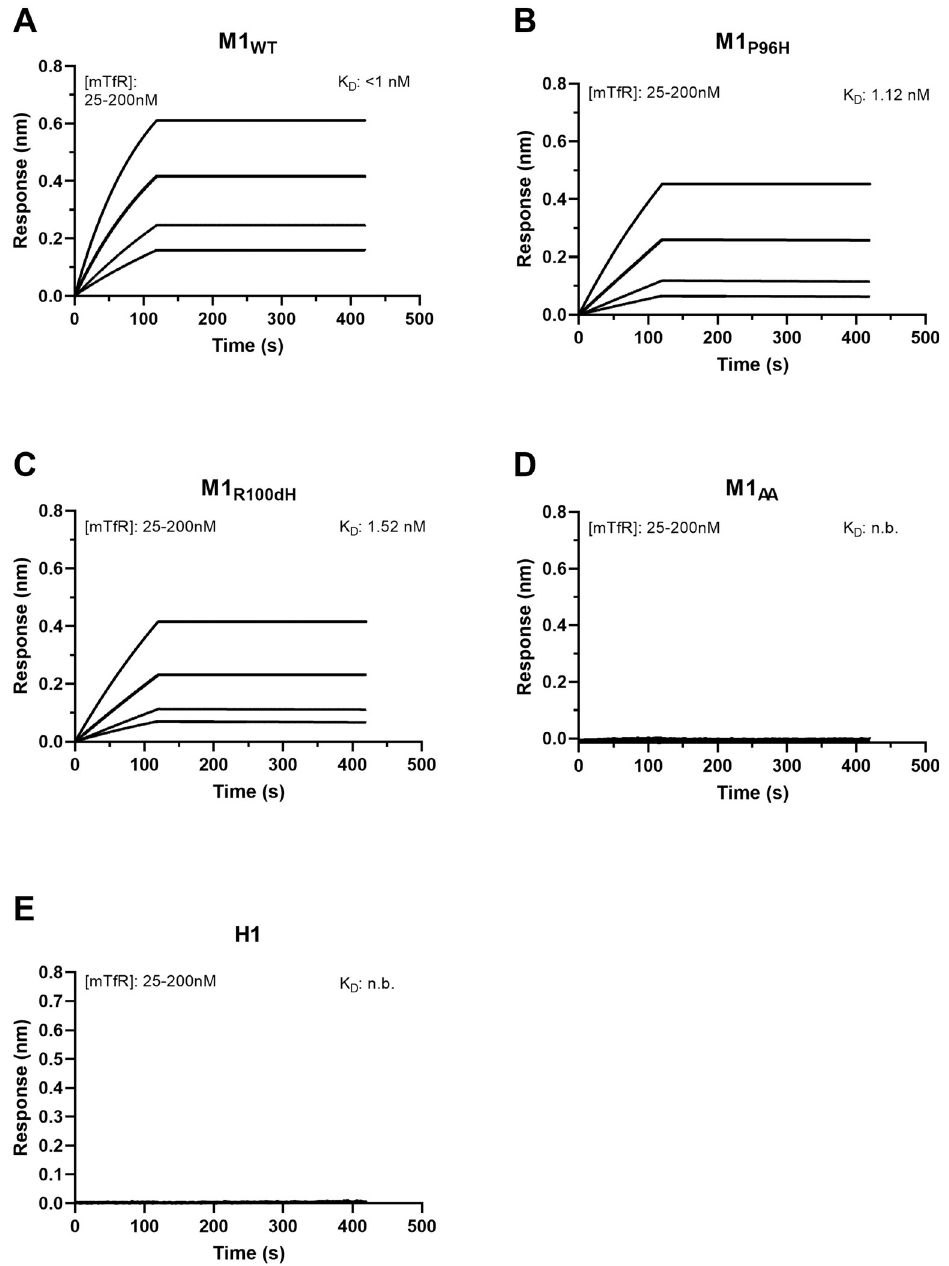
Fig 2. Affinity binding curves of the five M1-NT variants. M1 WT -NT ( A ), M1 P96H -NT ( B ), M1 R100dH -NT ( C ), M1 AA -NT ( D ) and H1-NT ( E ) binding affinity (K D ) to mTfR. Using biolayer interferometry on an Octet Red96 system, association and dissociation rates were determined by immobilizing biotinylated VHH onto streptavidin- coated optical sensors. The M1-NT variant association and dissociation curves to mTfR were plotted and the affinity of each to mTfR was calculated. (n.b. = no binding).